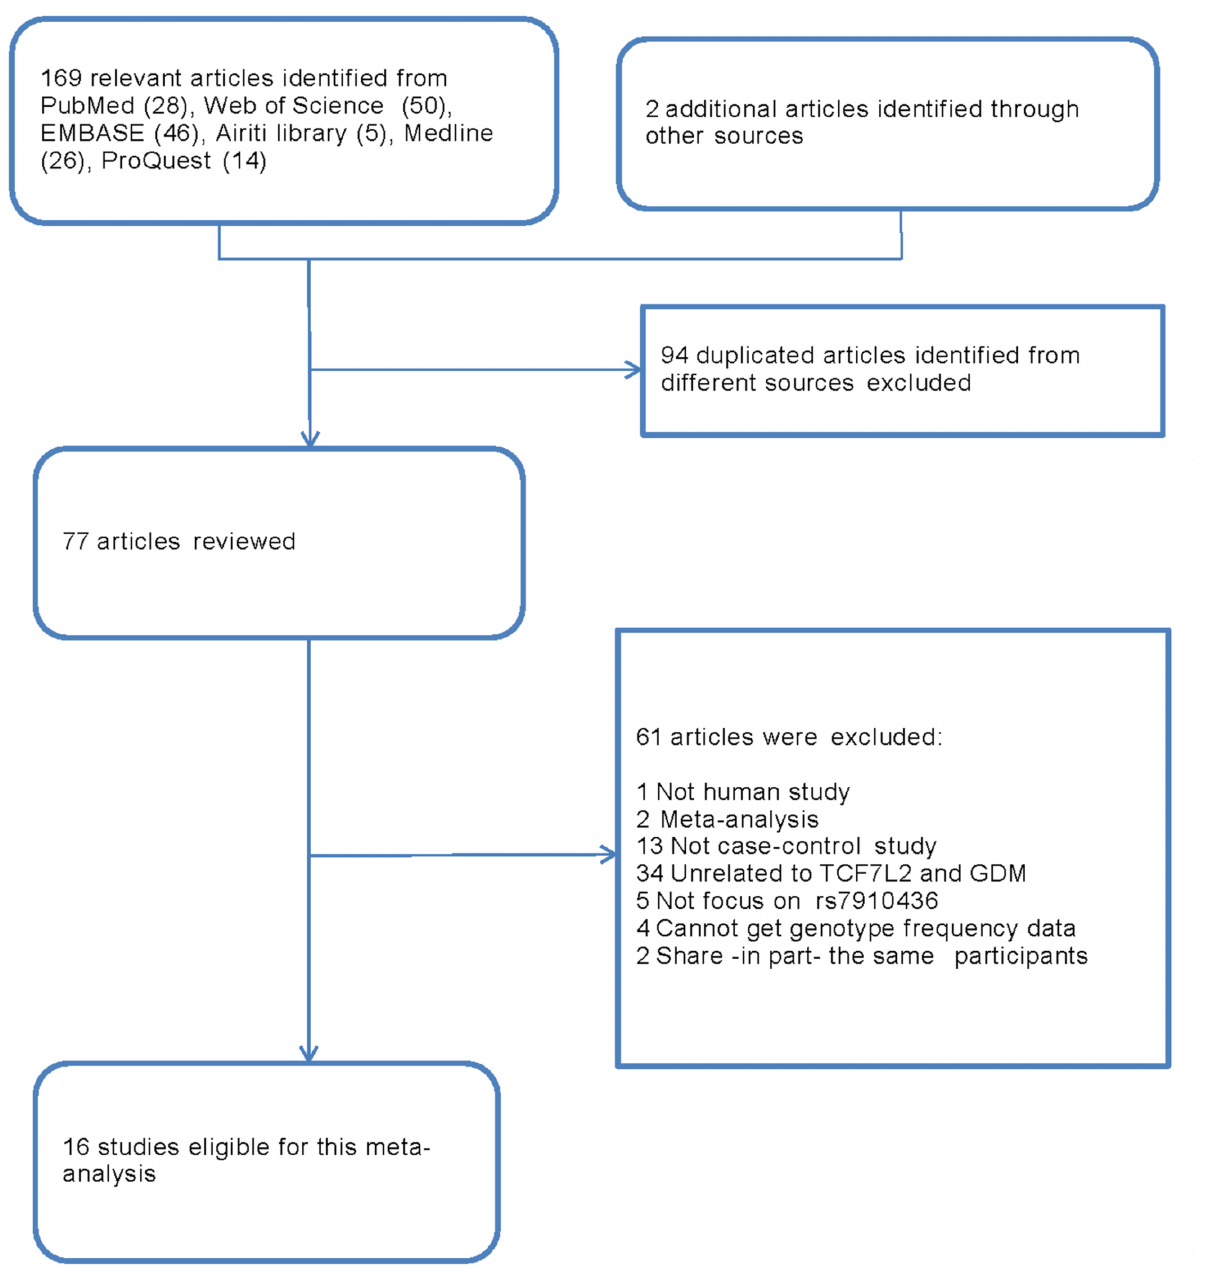
Fig 1. Selection of studies for inclusion in